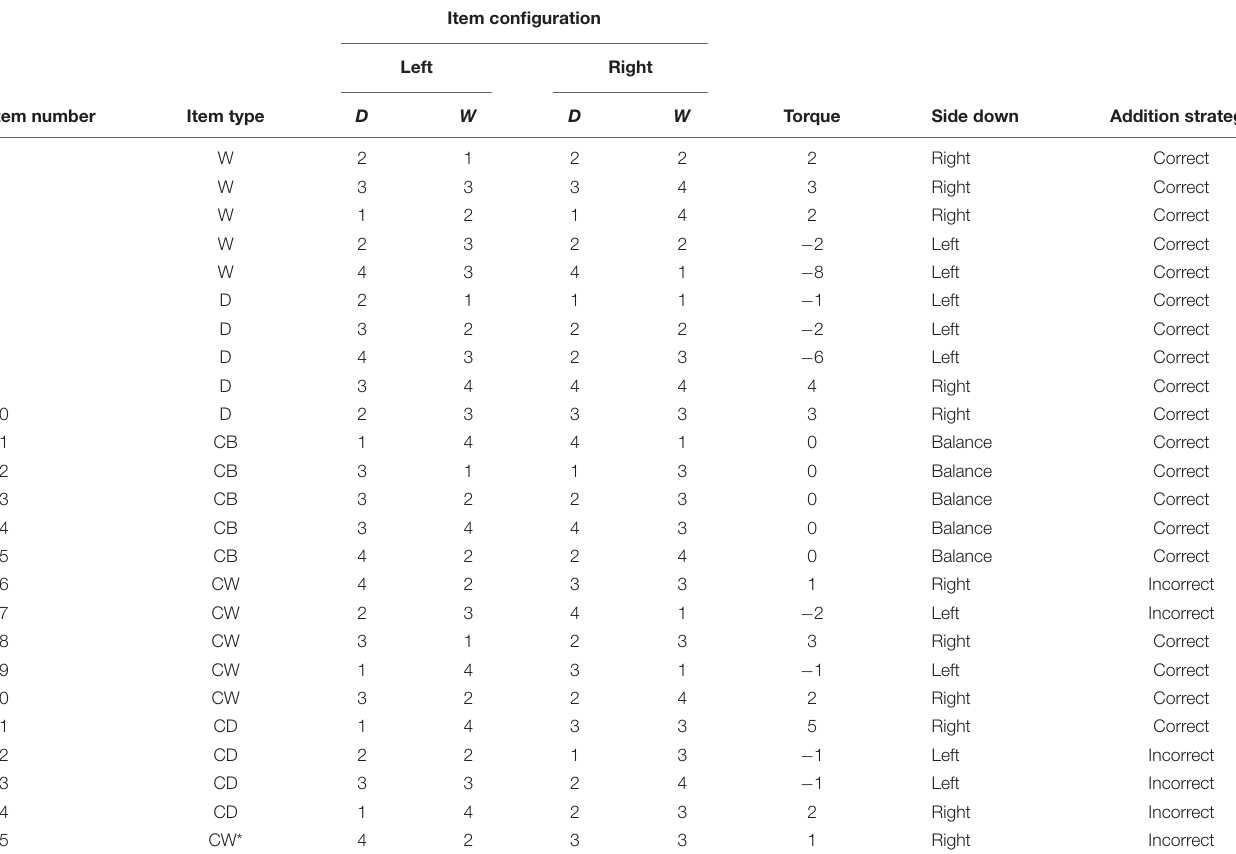
TABLE A1 | Item characteristics: number, type, weight, and distance on the left and right sides of the balance beam, torque, and which side goes down. Item